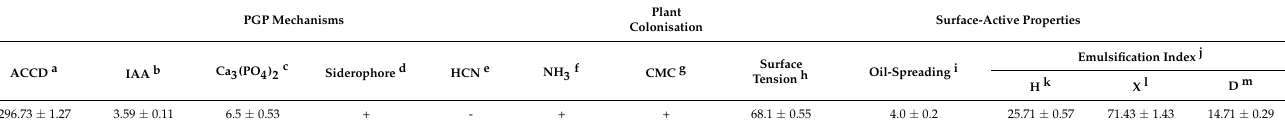
Table 1. The activity of the plant-growth-promoting mechanisms and surface-active abilities of the ZCR6 strain.